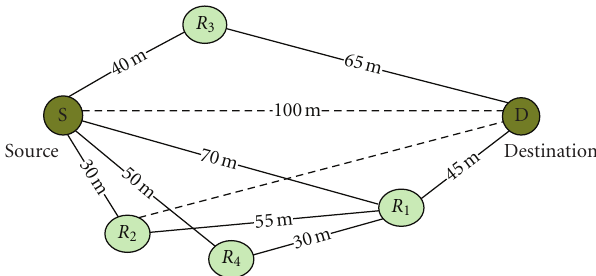
Figure 4: Network topology for cooperative routing simulations.